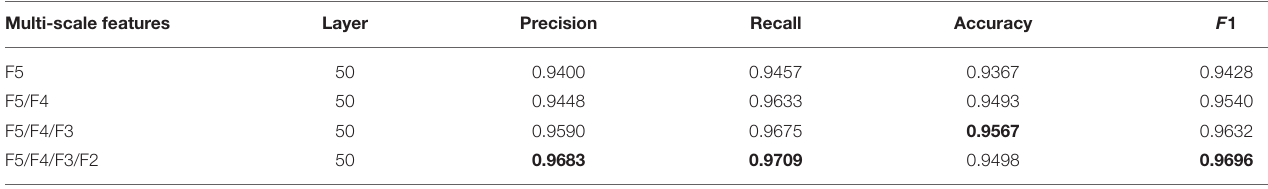
TABLE 2 | The experimental results of the ablation analysis of multi-scale features, the higher the values of precision, recall, accuracy, and F 1, the better the recognition performance. Multi-scale features Layer Precision Recall Accuracy F 1